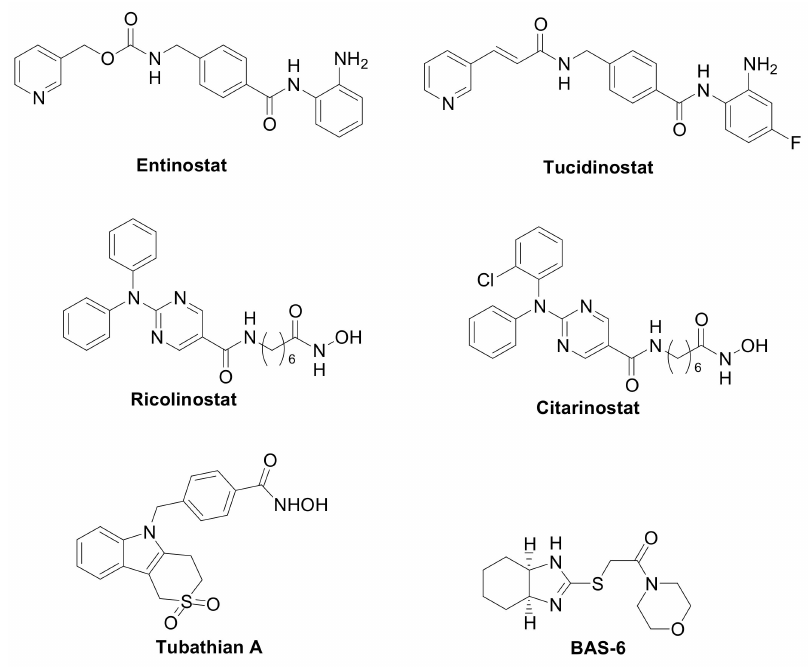
Figure 3. Class-selective HDAC inhibitors. Table 2. Summary of the main biological effects of HDACIs in TNBC cells. HDACIs Action